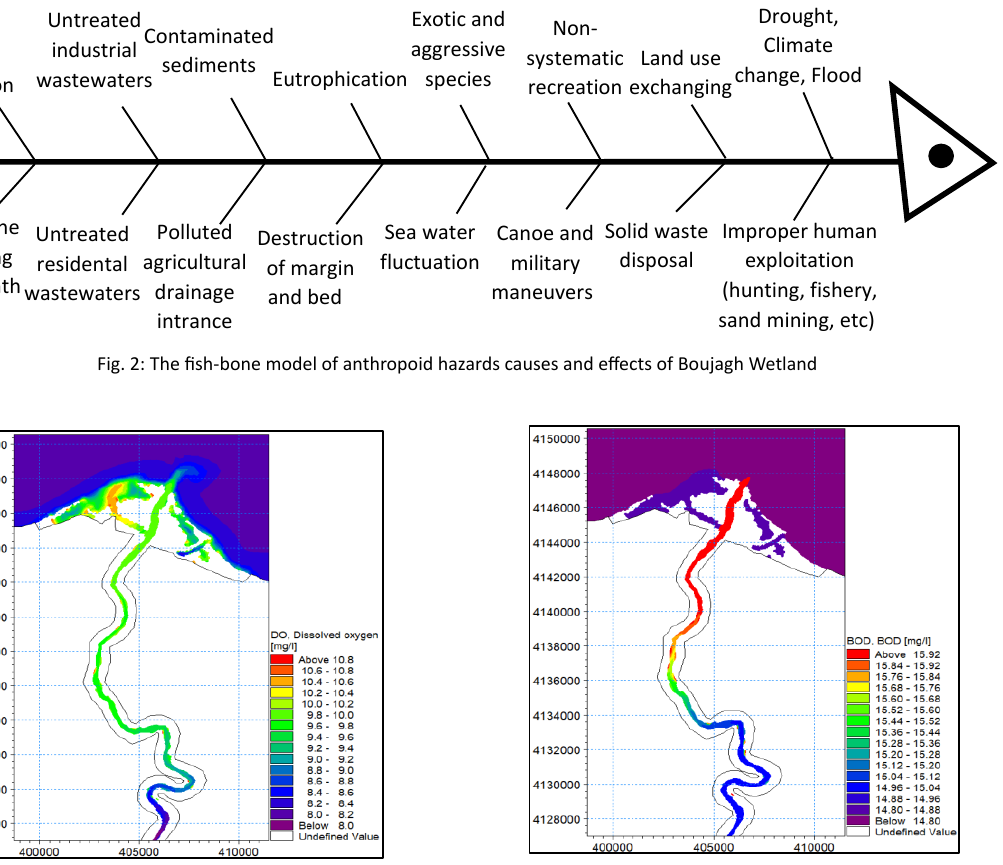
Fig. 3: DO fluctuations tendency Fig. 4: BOD fluctuations tendency